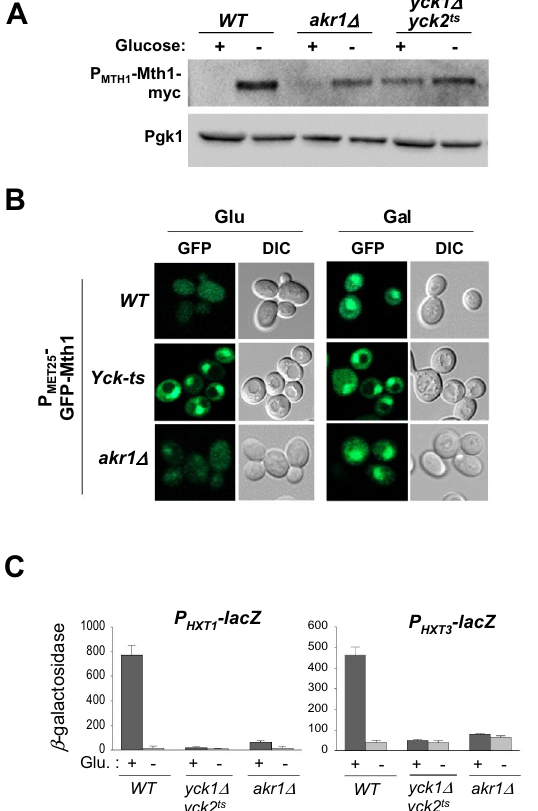
Figure 3. Glucose induces Mth1 degradation when both the Ycks and Rgt2 are present in the same cellular compartment. ( A ) Western blot analysis of the Mth1-myc protein from WT (LRB939), yck1Δyck2 ts (LRB1613), and akr1Δ (KLS61) strains with HA-specific antibody. The indicated yeast strains expressing Mth1-myc were grown to mid-log phase in a selective medium containing 2% glucose. Aliquots were then transferred to 2% glucose medium (Glu) or 2% galactose medium (Gal) and incubated for 1 h. ( B ) Yeast cells of the indicated genotype expressing GFP-Mth1 were grown as described above. Subcellular localization of GFP-Mth1 was analyzed by confocal microscopy. Cells were observed under the Zeiss LSM 510 META confocal laser scanning microscope. DIC and GFP fluorescence images are shown. ( C ) Expression of HXT1 and HXT3 genes in yck1Δyck2 ts and akr1Δ strains. β-Galactosidase activity was assayed in permeabilized cells and expressed in Miller Units. Values are means for at least three independent